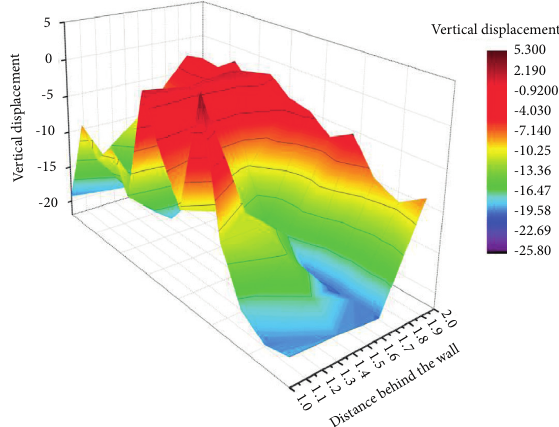
Figure 15: Vertical displacement of the surface behind the wall.